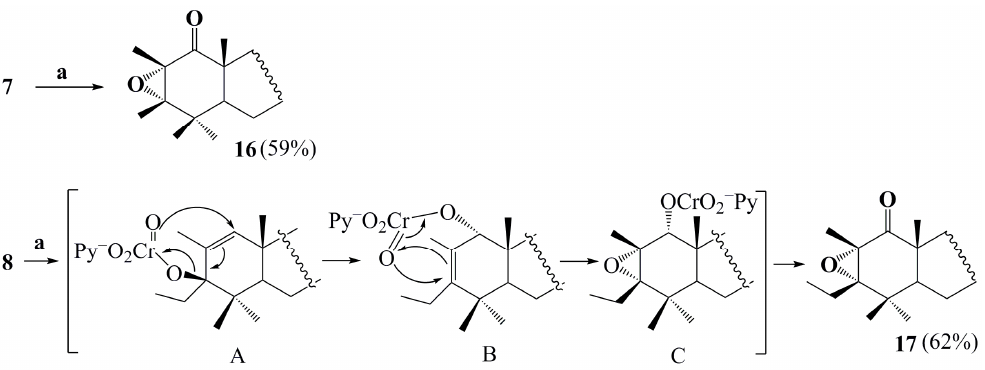
Scheme 3. Synthesis and plausible mechanism for the formation of 2,3 α -epoxides 16 and 17 . Reaction conditions: ( a ) CrO 3 · Py · HCl (PCC), CH 2 Cl 2 , rt.